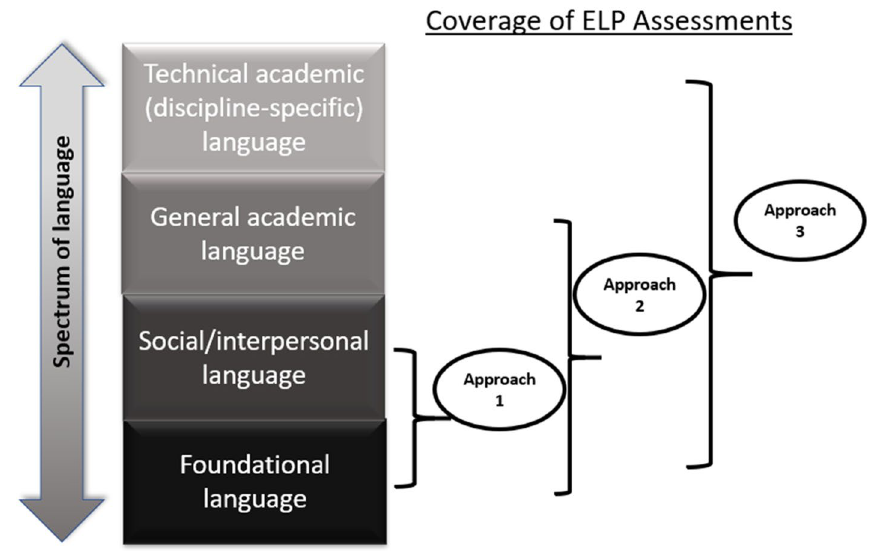
Fig. 2 Different approaches to cover the ELP construct across ELP